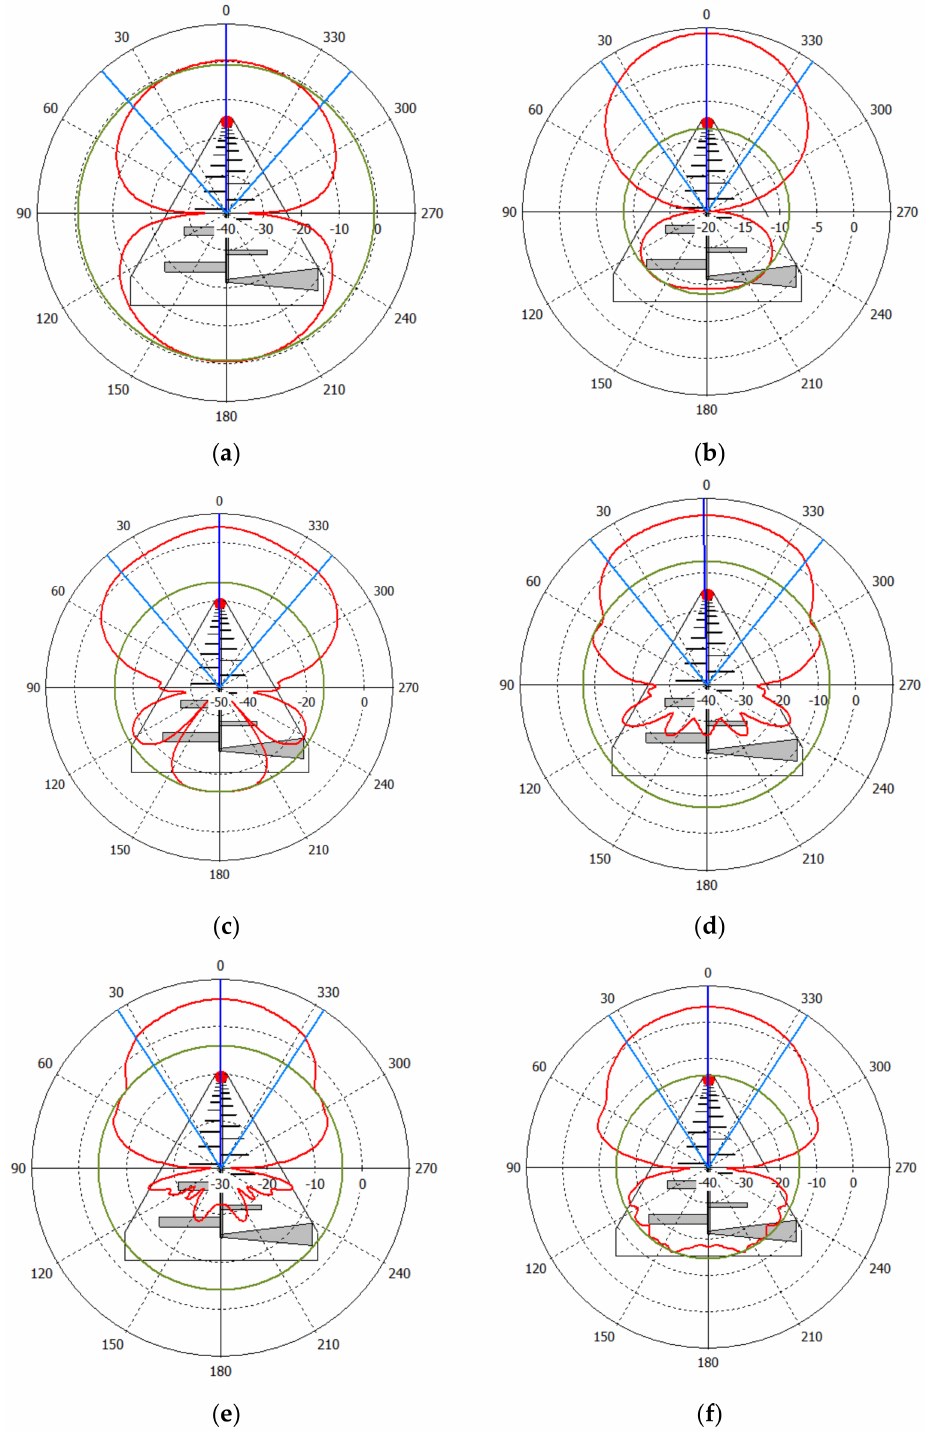
Figure 18. Polar plots of the E-plane radiation patterns of the proposed antenna at ( a ) 0.4 GHz, ( b ) 0.8 GHz, ( c ) 2 GHz, ( d ) 4 GHz, ( e ) 6 GHz, and ( f ) 8